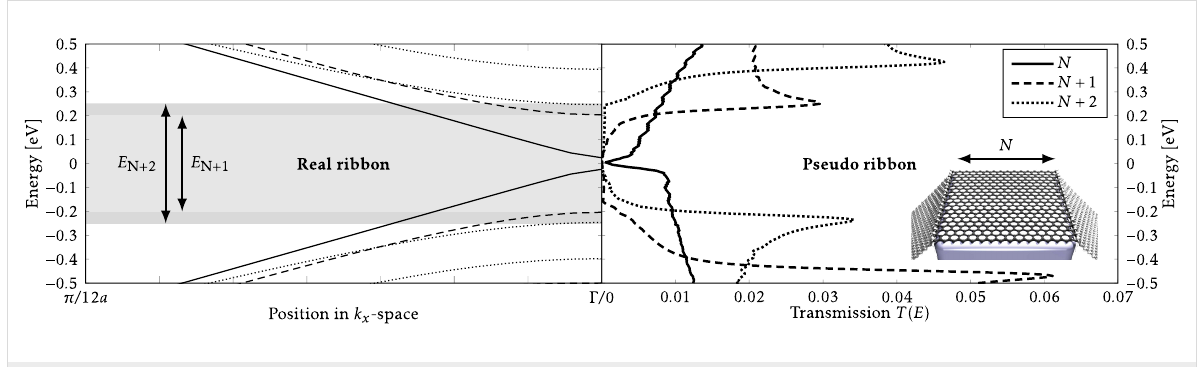
Figure 4: (Left) Band structures for H-passivated armchair ribbons with varying width, N . The ribbons are a zero-gap semiconductor, a semicon- ductor with band gap E N+1 = 0.4 eV, and a semiconductor with band gap E N+2 = 0.5 eV for widths N , N + 1, N + 2, respectively. All widths are based on the number of carbon atom lines N = 17. The band gaps are indicated by arrows and are highlighted. (Right) The electronic transmission functions for the corresponding pseudo-ribbons, i.e., across two parallel kinks of varied separation as shown in the